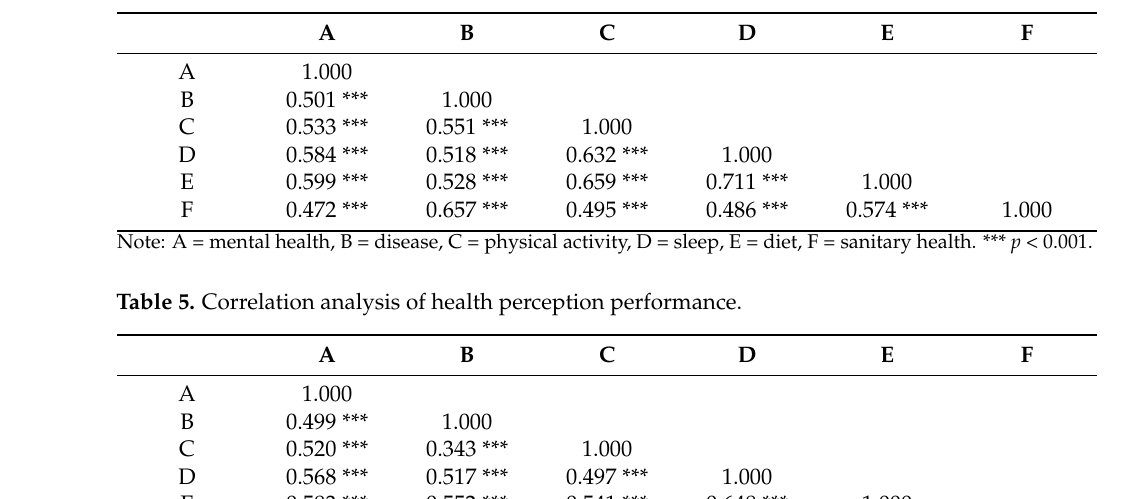
Table 4. Correlation analysis of health perception importance.